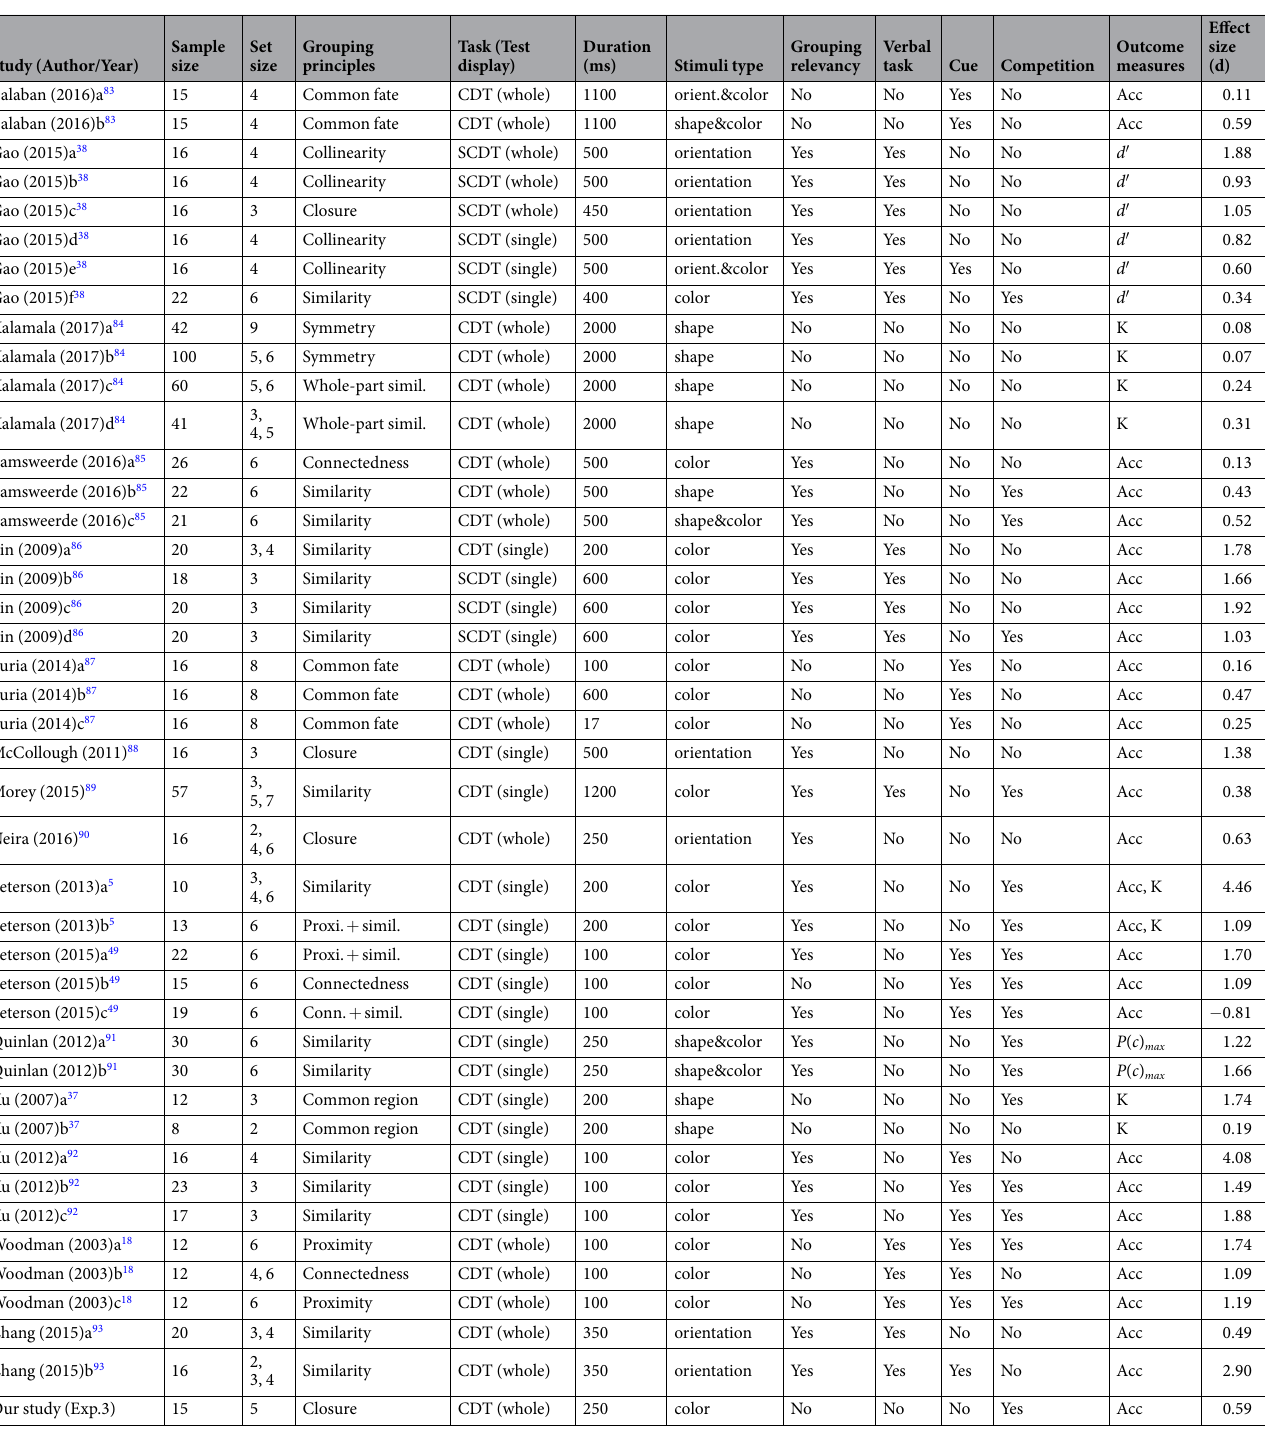
Table 1. Characteristics of Individual